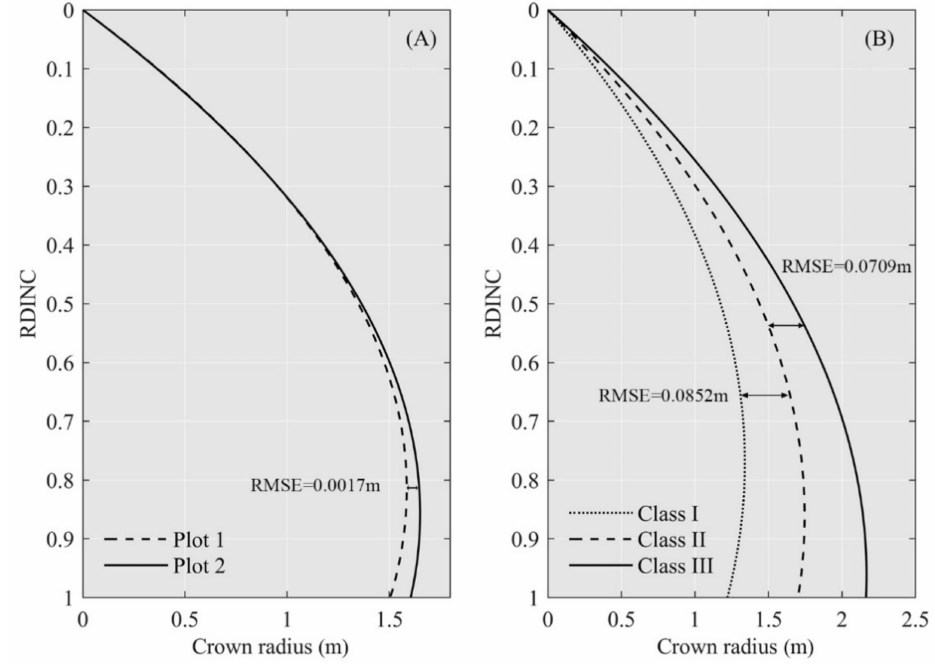
Figure 8. Curve fitting for ( A ) di ff erent stand densities and ( B ) di ff erent diameter classes using the parabola